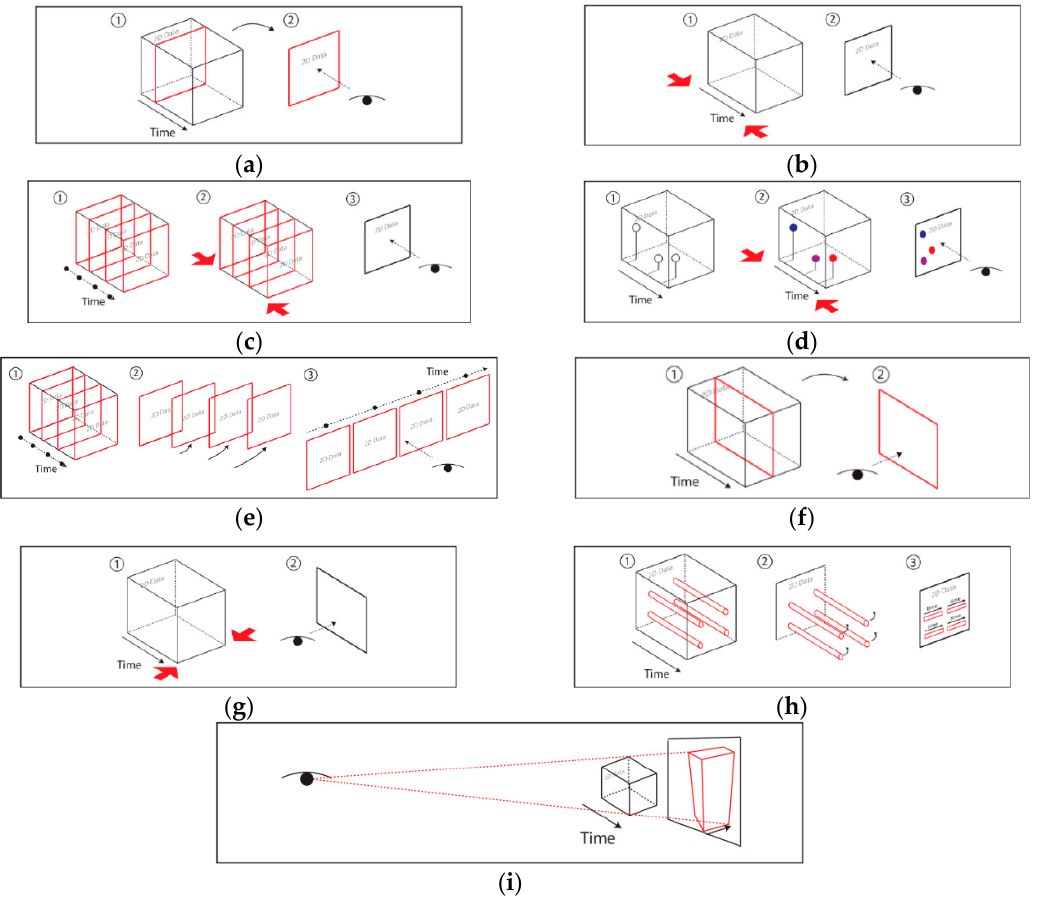
Figure 8. Static visualizations as space–time cube operations [27]: ( a ) time cutting; ( b ) time flattening; ( c ) discrete time flattening; ( d ) colored time flattening; ( e ) time juxtaposing; ( f ) space cutting; ( g ) space